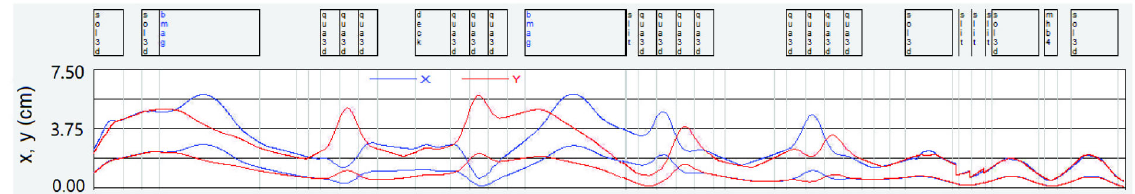
FIG. 18. TRACK simulation of the beam envelope with the realistic particle